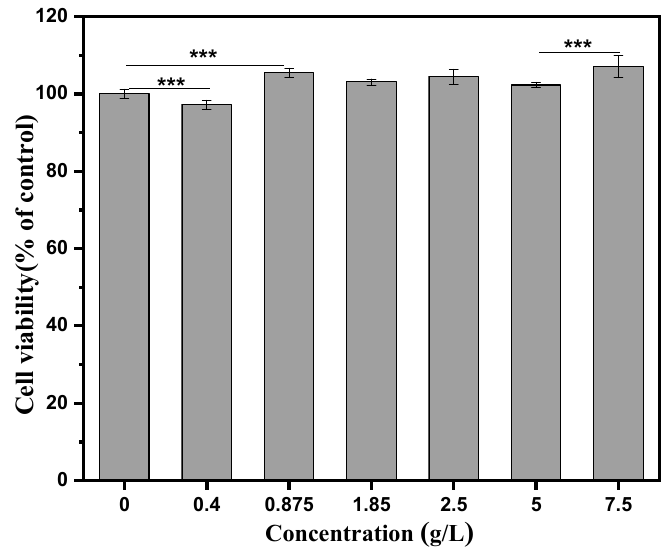
Figure 8. Cell viability of CS/CMS-lysozyme microspheres by CCK8 assay. The data of cell viability were analyzed using a two-tailed unpaired Student’s t -test. The error bars indicate means ± SD and n = 8. ***: p < 0.001.